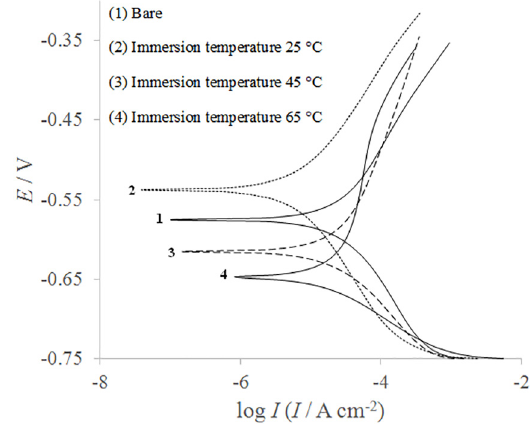
Figure 4. Potentiodynamic polarization curves of cerium-coated steel in 3.5 wt% NaCl solution. Conversion coatings were